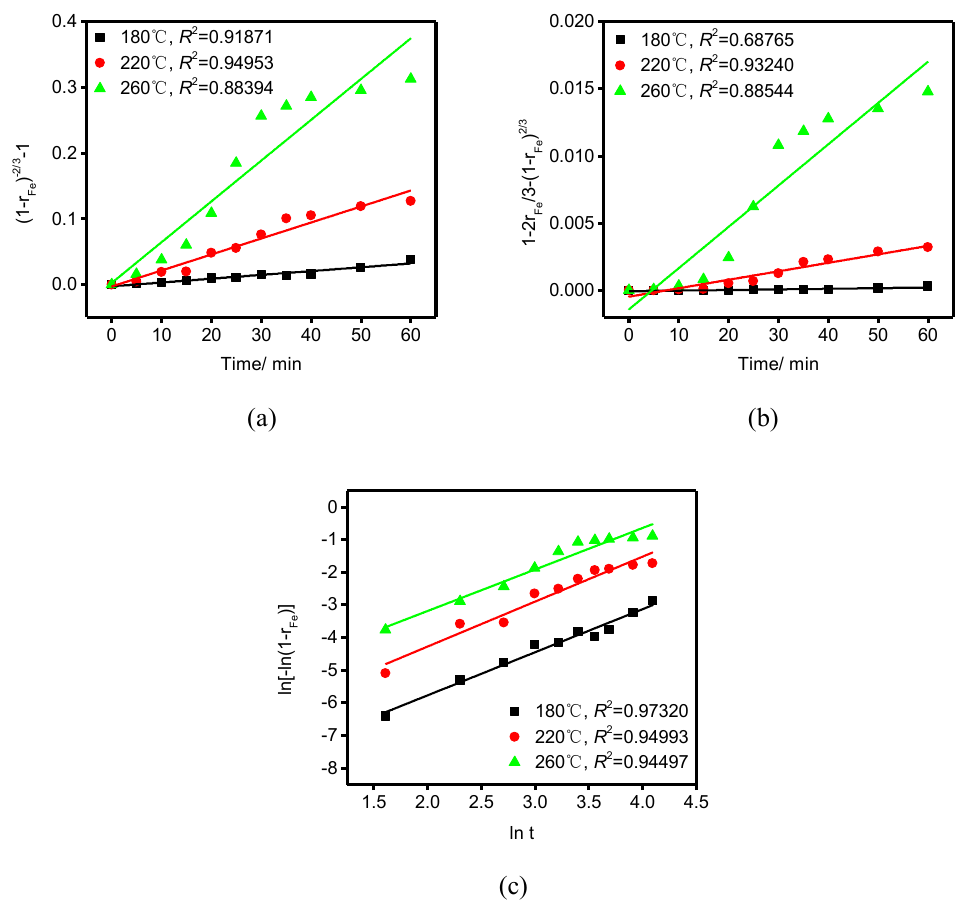
Figure 10. Comparison between plots of (a) (1 − r Fe ) -2/3 − 1 and (b) 1 − 2 r Fe /3 − (1 − r Fe ) 2/3 vs time,